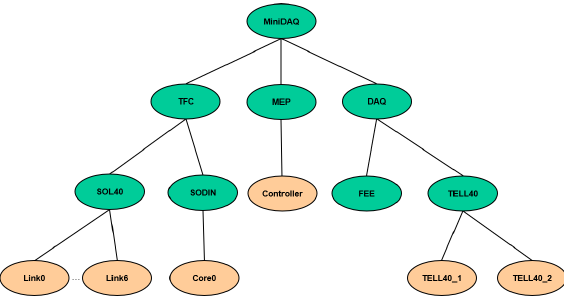
Figure 4. MiniDAQ Run Control FSM